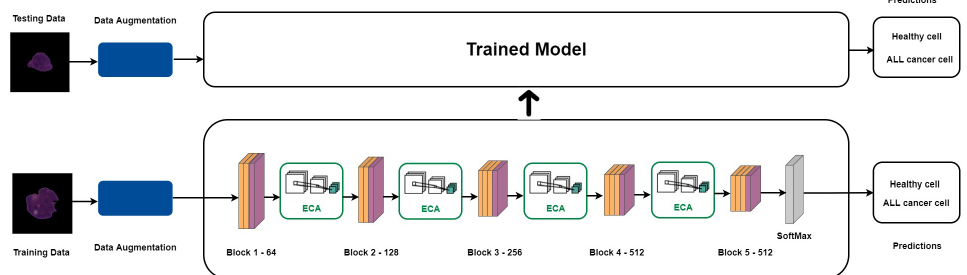
Figure 4. Our proposed model for the classification of ALL cell